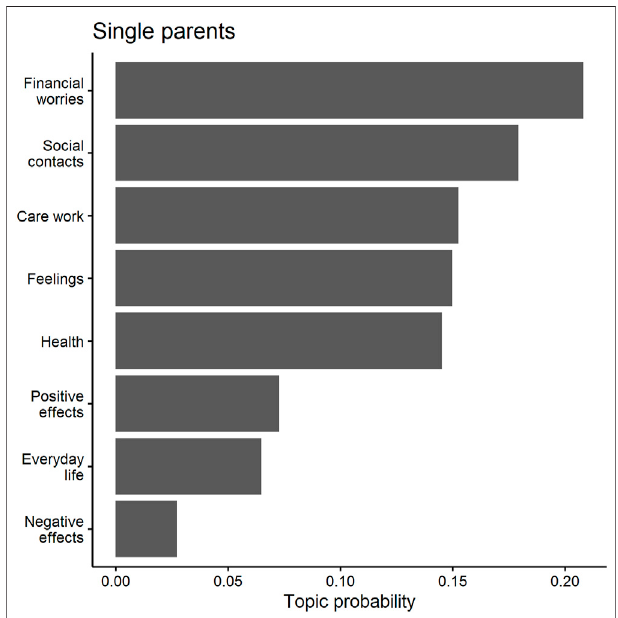
FIGURE 2 | Predicted topic probabilities for single parents.